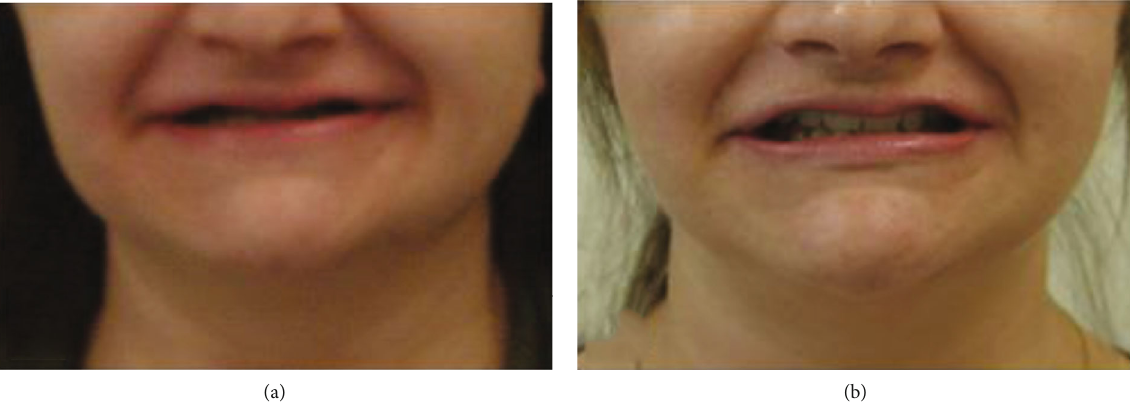
Figure 7: Comparison of facial appearance before (a) and after (b) treatment. (a) While smiling, maxillary teeth are not visible, giving impression that patient is edentulous. (b) Anterior teeth are visible during smile and dental midline correlates with facial